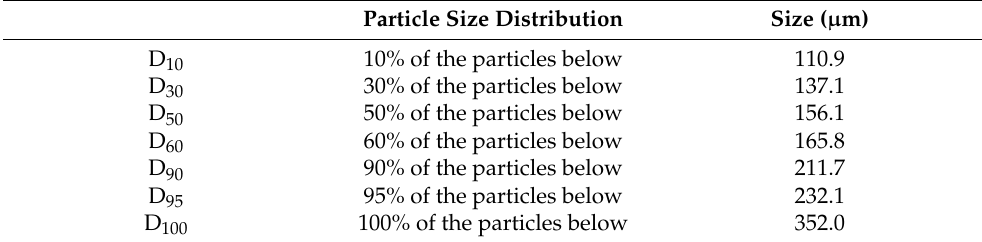
Table 3. WFES particle size